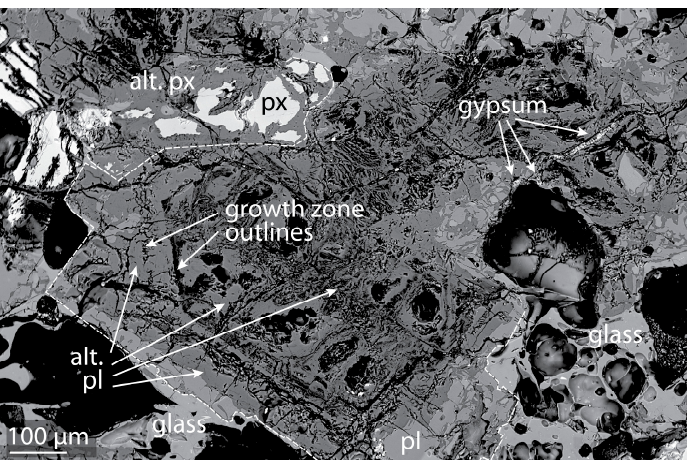
Figure 4. Back-scattered electron image of strongly altered area from the 100 °C experiment. Zoning in the original plagioclase is marked by changes in the texture of the opaline silica alteration product. The sodic rim of the plagioclase is preserved, whereas the core is altered and is starting to disintegrate. Pyroxene is similarly altered to opaline silica, but alteration does not follow growth zoning. Glass in the matrix and present as inclusions is preserved. Gypsum is present as vein infill in the altered plagioclase. Abbreviations as in Figure 2.